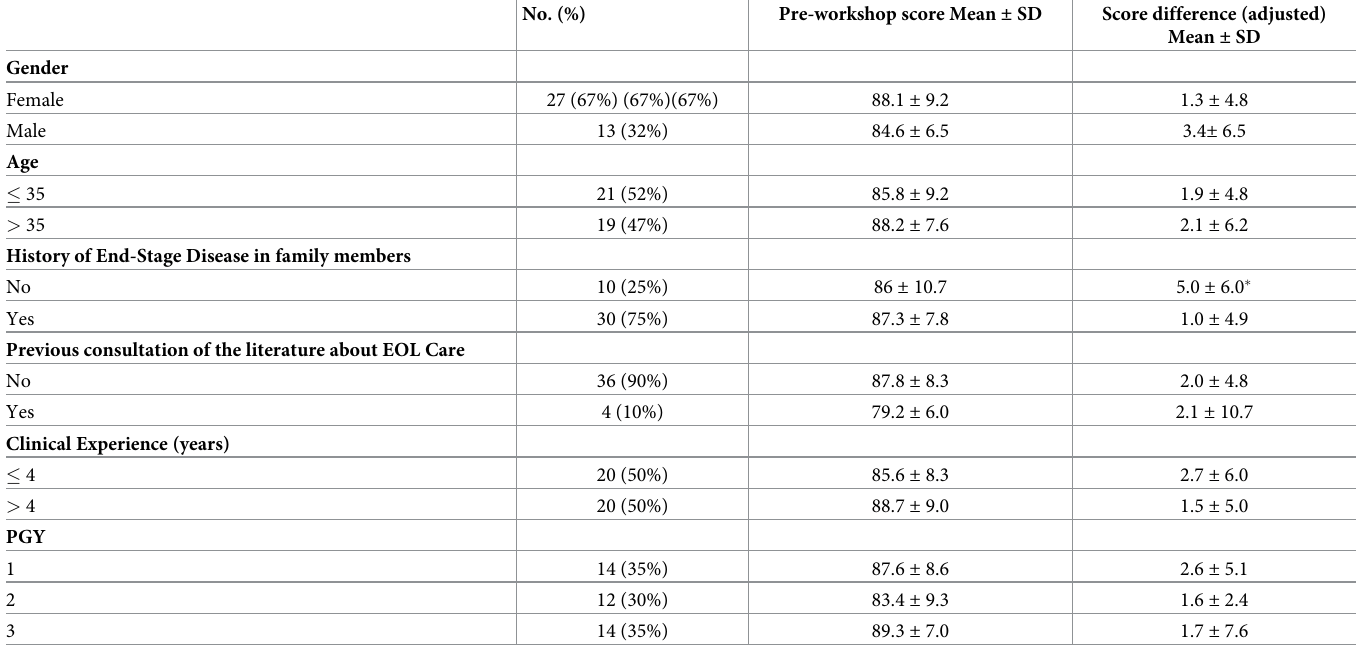
Table 2. PEAS score before workshop and PEAS score difference at 4-week follow-up among group of gender, age, history of end-stage disease in close relatives, pre- vious consultation of the literature about EOL care, years of clinical experience, and PGY (Postgraduation